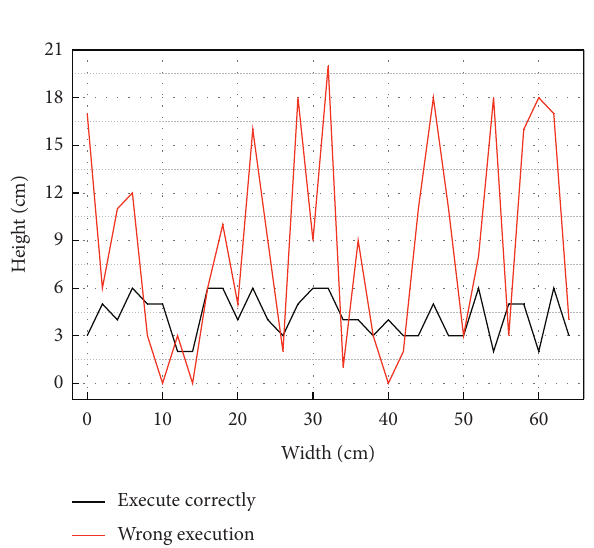
Figure 10: Experimental motion trajectory